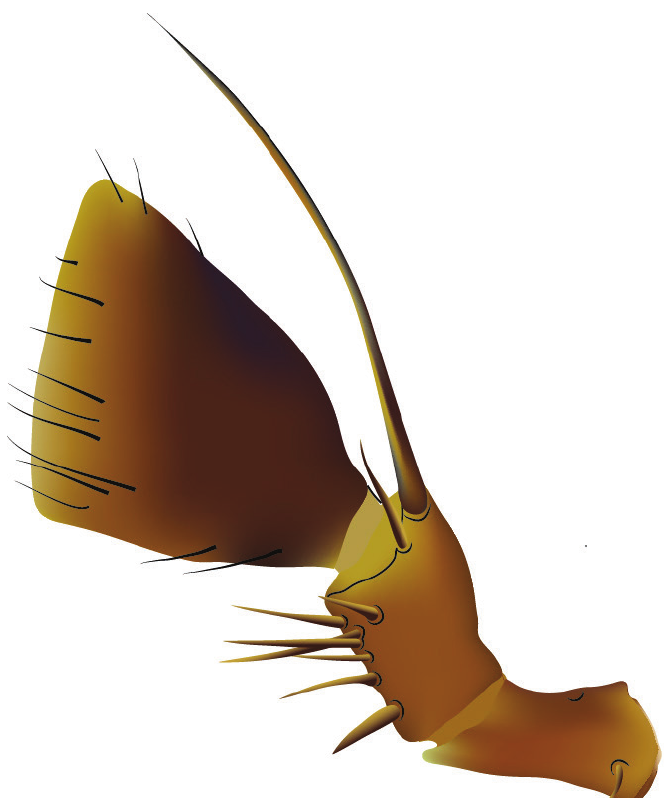
Figure 6. Labial palpi of Quediopsis howensis Jenkins Shaw & Solodovnikov, sp. n. Antennomeres elongate, all of same colour. First antennomere slightly expanded apically, about as long as second and third combined. Pronotum widest behind its middle at ca. posterior 2/3 of its length, slightly nar- rowed towards front angles; usually lighter than head in colour. Dorsal area with linear microsculpture and micropunctures visible at 40× magnification. Pronotal disk with two punctures in dorsal row: one very close to anterior margin of pronotum, and one on disc of pronotum before middle. Hypomeron inflexed and therefore not visible in lateral view, without post-coxal process. Basisternum with pair of black macrosetae and sometimes with other macrosetae positioned anterior to them. Elytra usually the same colour as head, brown, sometimes with area around suture and scutellum rufous. Scutellum with only anterior scutellar ridge, setiferous in apical area. Sub-basal ridge present, not reaching humeral angles. Humeral angles with ran- domly positioned spine-like setae. Wings reduced, much shorter than elytra. Legs concolourous. Tarsal formula 5-5-5. Both sexes with protarsi dilated and bearing dense white adhesive setae ventrally. Each tarsus with pair of empodial setae. Metacoxae almost parallel-sided along their entire